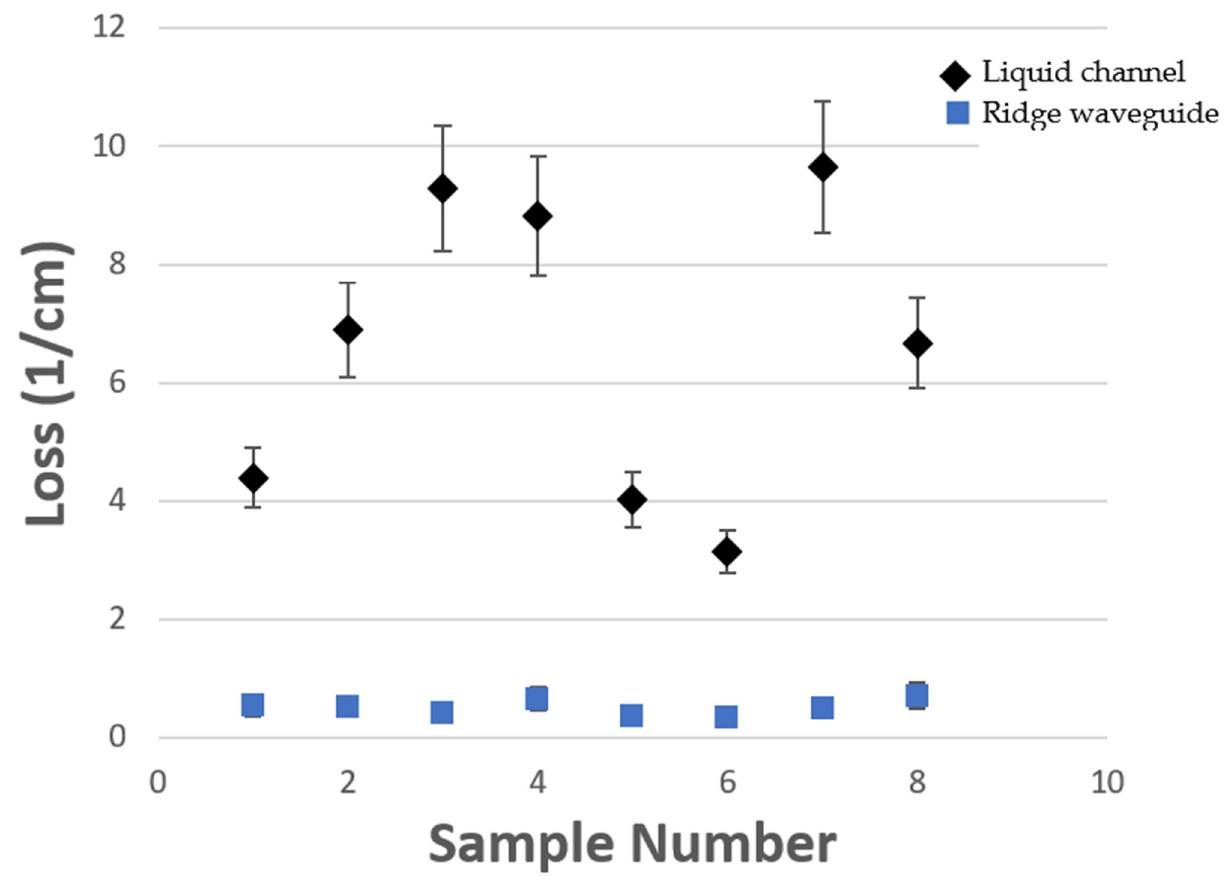
Figure 8. Liquid-channel (diamonds) and solid-core ridge waveguide (squares) loss coefficient values for eight devices with uncertainty bars.